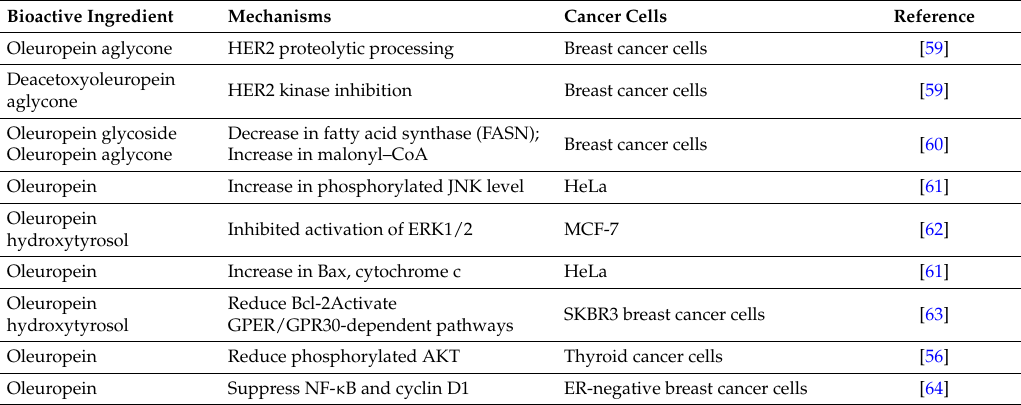
Table 3. Anticancer effects of Oleuropein and its